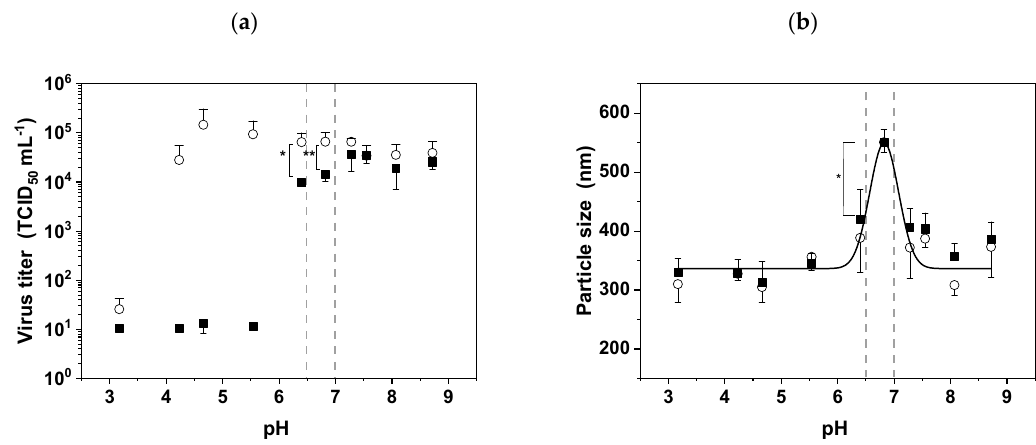
Figure 3. The stability of MV is dependent on pH. ( a ) The infectivity of MV was determined immediately after adjusting the pH (open circles) by diluting MV suspensions 1:10 in the appropriate buffer, and after incubation at room temperature for 1 h (black squares). ( b ) The pH-dependent increase in particle size was measured by dynamic light scattering (DLS) immediately after dilution (open circles) and after incubation at room temperature for 1 h (black squares). Data are means plus standard deviations ( n = 3; * p ≤ 0.05 and ** p < 0.1).